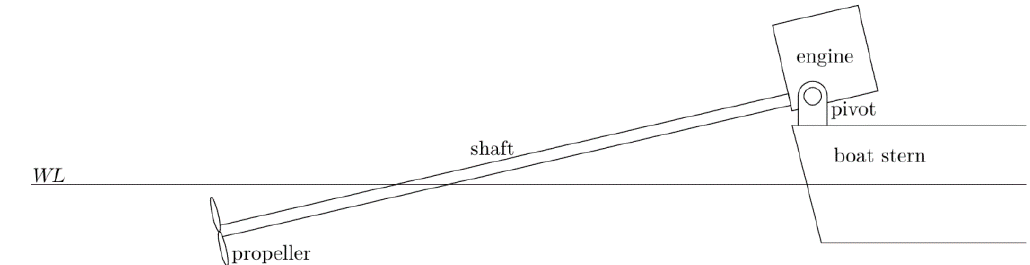
Figure 1. Typical configuration of long-tail boats in ASEAN.